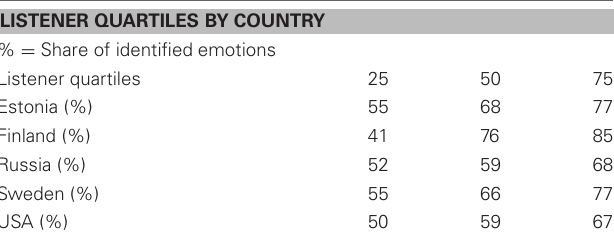
Table 7 | Test of model effect in the logistic regression model of the combined effects on the identification of the